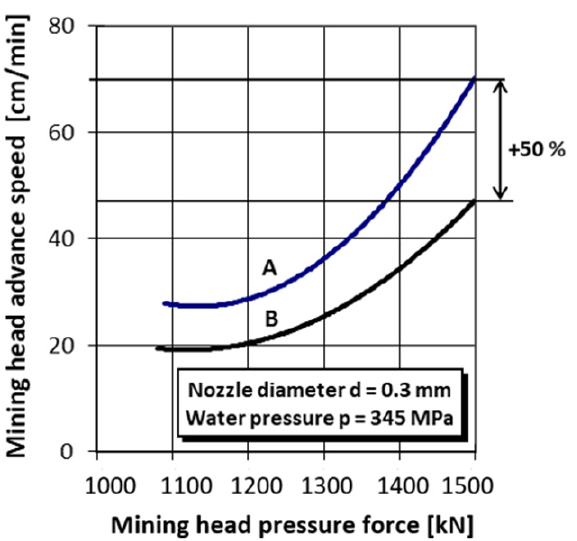
Figure 4. Influence of pressure force on the speed of mining head advance: A—with HPW assistance, B—without HPW assistance [7].